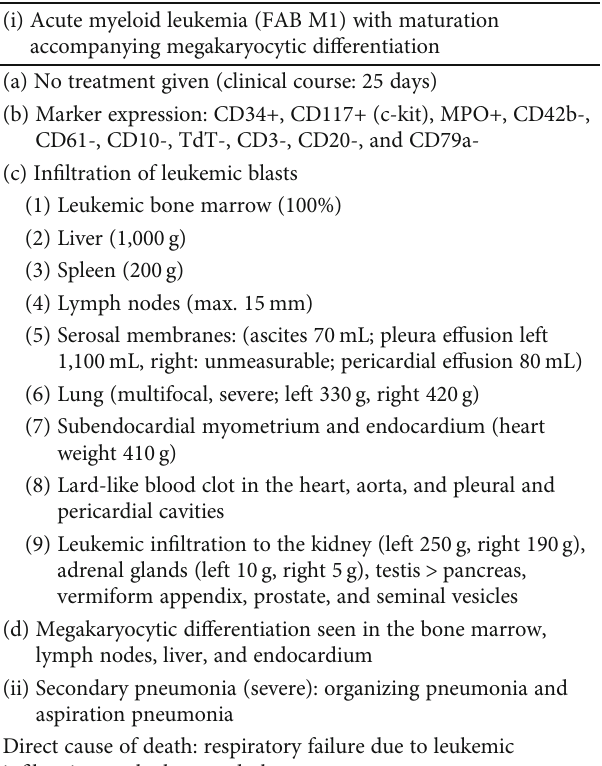
Table 1: The fi nal anatomical diagnosis (85-year-old